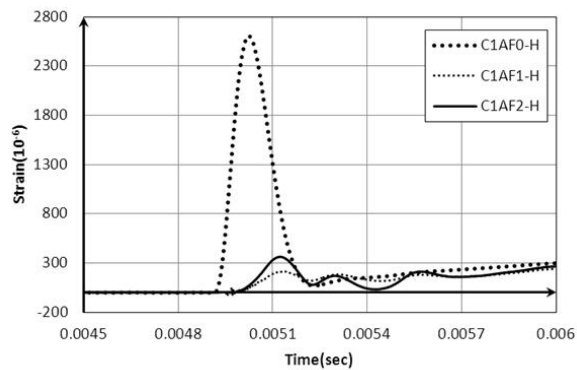
Figure 6. Measured strain history of concrete